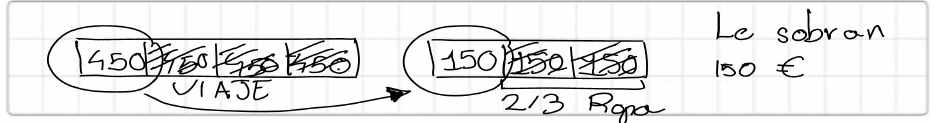
Figure 7. PT178’s written answer to problem FWP4. (Translation of PT178’s solution: “EUR 150 left over.” (VIAJE is translated as Trip, and Ropa as clothe)]).